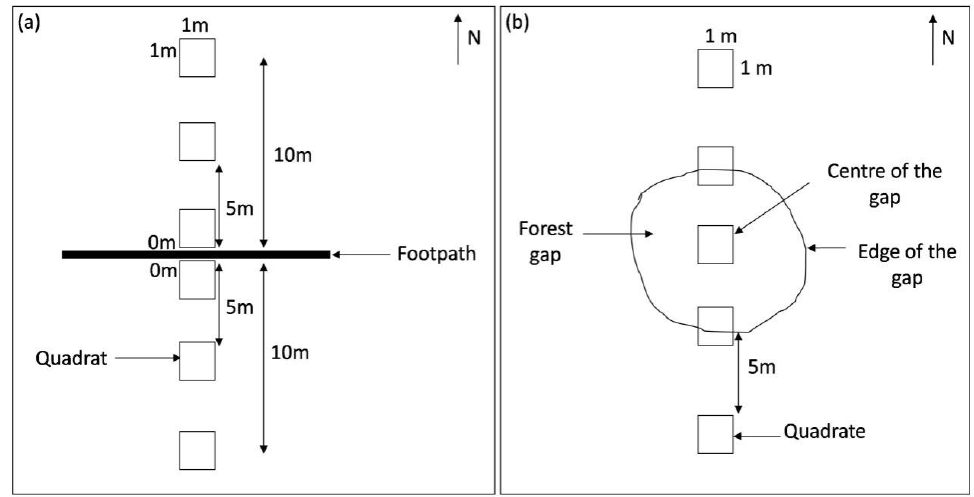
Figure 2 : a) The layout of the quadrats along footpaths and b) in forest